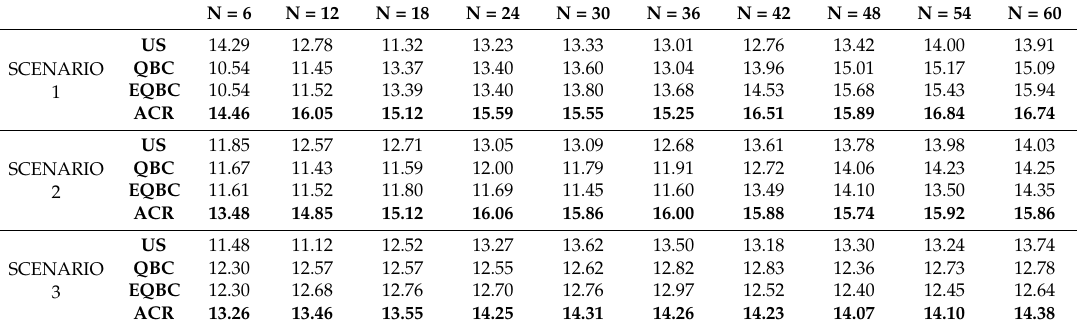
Table 3. Labelling efficiency index (LEI) ( k -NN) in Scenario 1–3